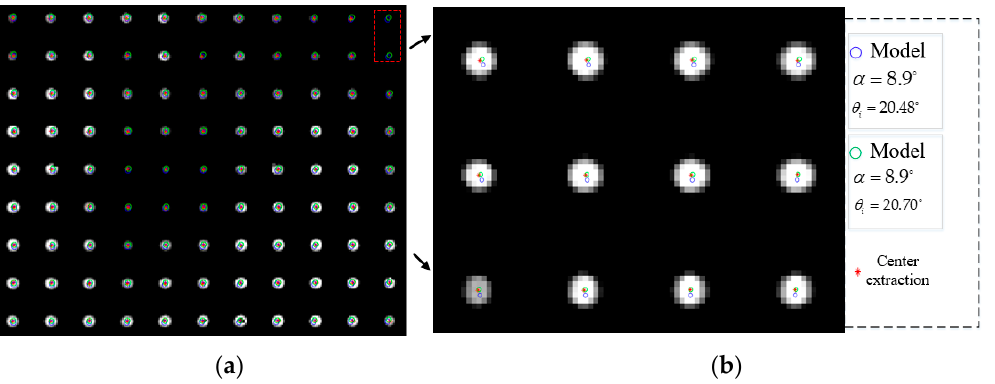
Figure 11. Spectral imaging experiment based on mid ‐ infrared AOTF. ( a ) Actual image of diffracted light; ( b ) the partially enlarged view of the target. light; ( b ) the partially enlarged view of the target.